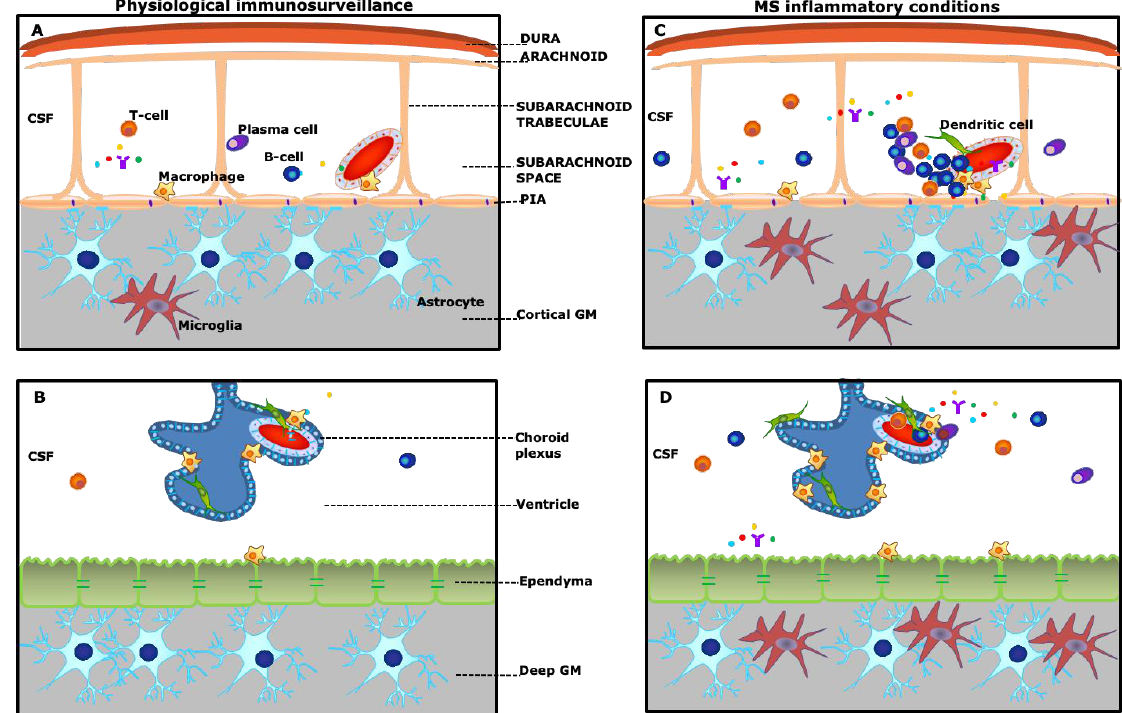
Figure 1. Schematic overview of “meningeal and choroid plexus immunity” ( A , B ) and pathological alterations in multiple sclerosis (MS) ( C , D ). ( A ): The meninges consist of di ff erent membranes, including the dura mater (periosteal and meningeal layers), the arachnoid, and the pia. Strands of connective tissue, or arachnoid trabeculae, extend from the arachnoid layer and contains the vascular system. Under physiological conditions, the subarachnoid space is populated by scattered B- and T-cells, plasma cells, and macrophages and is filled with the cerebrospinal fluid (CSF) bathing the cortical grey matter (GM). ( C ): In MS, either innate or adaptive immune cells, in particular B-cells, accumulate in the subarachnoid space, outside the meningeal vessel, and may form ectopic tertiary lymphoid-like structures (TLSs), which are in close contact with the pia mater. This compartmentalized meningeal inflammation may contribute to the release in the CSF of inflammatory mediators that di ff use through the pia and induce subpial cortical demyelination. ( B ): The choroid plexus (CP) stroma is irrigated by fenestrated microvessels allowing free di ff usion of blood-borne molecules. The CP epithelium surrounds the stroma and forms the blood–CSF barrier. Under physiological conditions, dendritic cells, macrophages, and sparse T-cells are found in the choroid plexus stroma. ( D ): During chronic neuroinflammation, both innate and adaptive immune cells accumulate in the choroid plexus and release inflammatory and proinflammatory factors in the surrounding CSF. These inflammatory changes may possibly induce changes in the structure and function of the ependyma lining the ventricle and the sub-ependymal glia, similar to those observed in the subpial